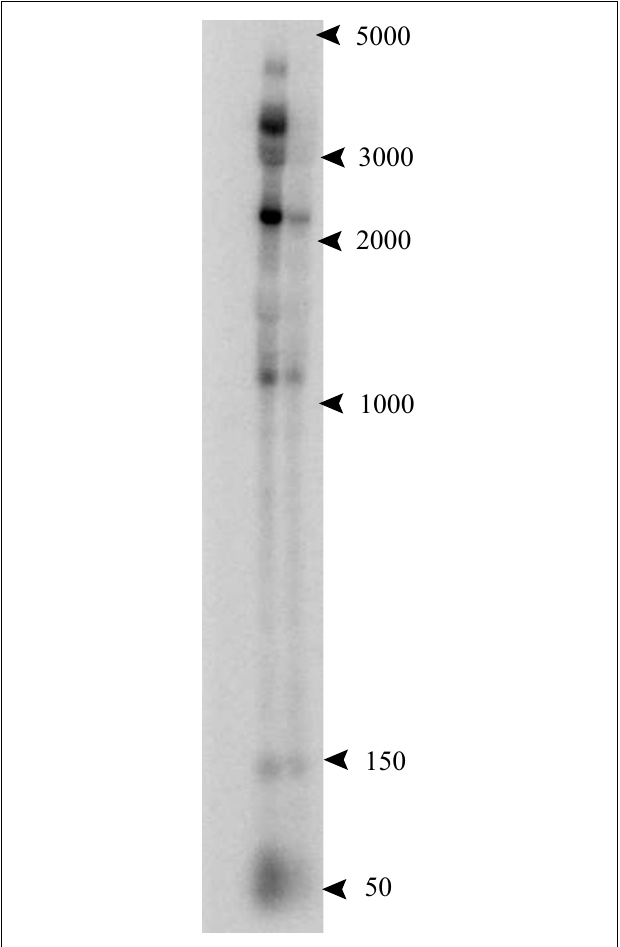
FIGURE 3 | Northern analysis of the 3 (cid:48) UTR of the electron transport flavoprotein ( etf ) operon. P. aerophilum total RNA, exponential phase (left lane) and stationary phase (right lane).The probe was designed to anneal beyond the stop codon of the terminal gene in the etf operon, in the region of the convergently oriented PAEsR53 C/D box sRNA. Multiple bands at 3400, 2250, and 1040nt are consistent with the etf operon and suboperon transcripts.The band near 50nt, consistent with the RNA sequencing data, shows an apparent antisense transcript to PAEsR53 (sense relative to the 3 (cid:48) UTR of the etf